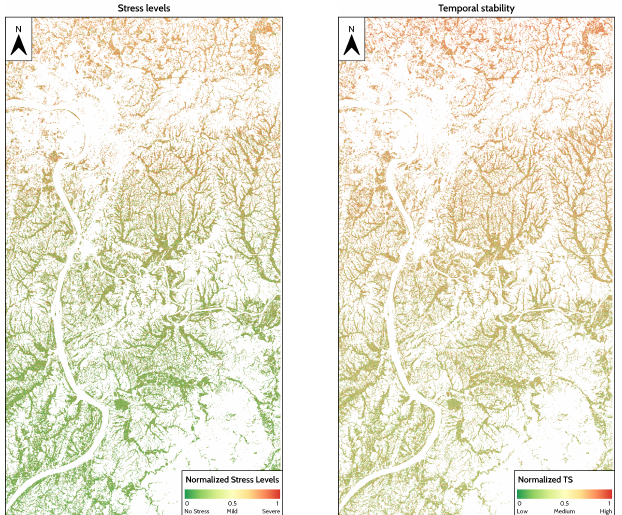
Figure 8. Spatial distribution of normalized stress levels and temporal stability measured by DTW. ( Left ): Normalized stress levels in 2018, ranging from 0 to 1. A high value indicates the pixel is under high stress level. ( Right ): Normalized temporal stability from 2017 to 2018 ranging from 0 to 1. A high value indicates that the pixel is stable, whereas a low value indicates that the rice pixel is